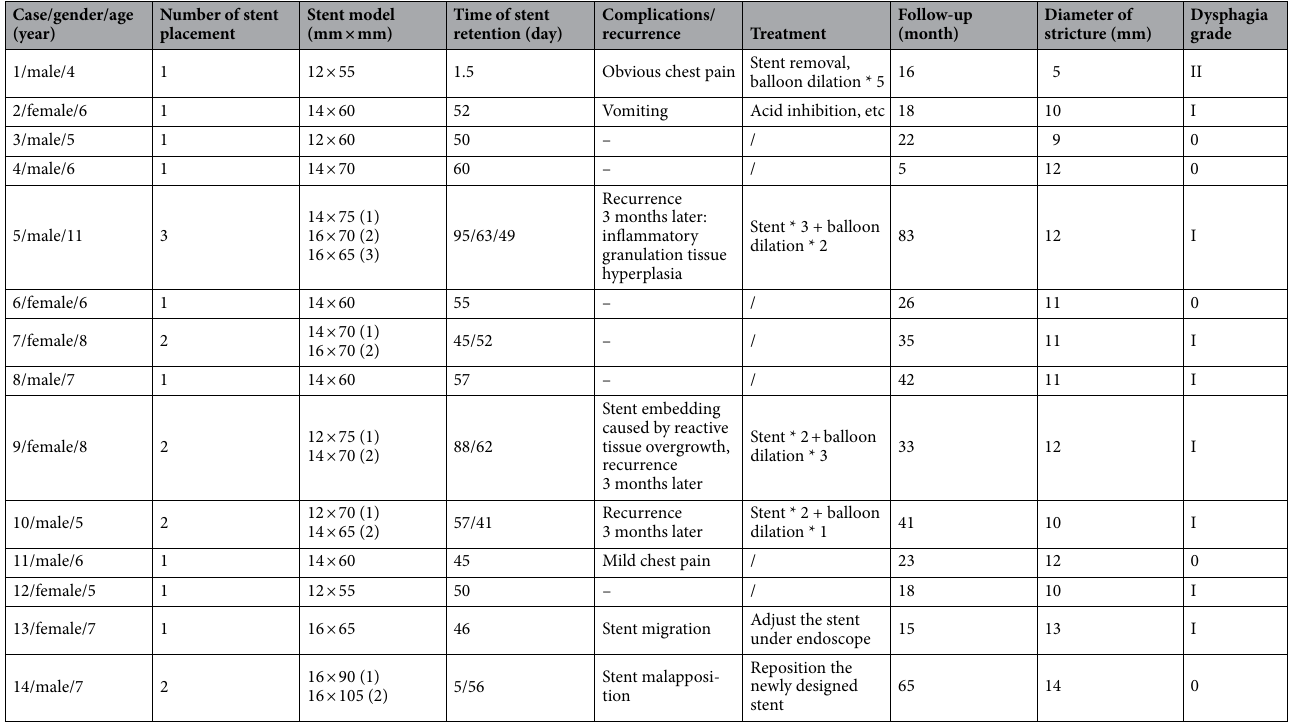
Table 2. Treatment outcomes and complications after stent placement. –, no complication and recurrence. /, no